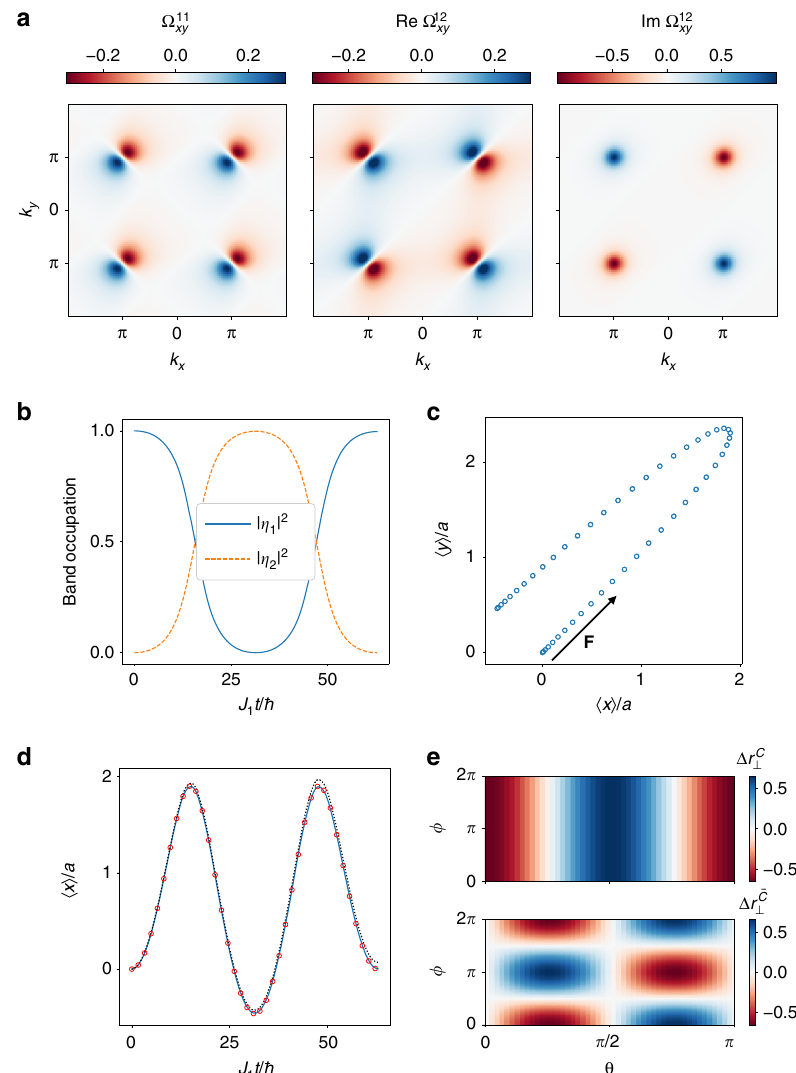
Fig. 2 Time dynamics of multiple BOs. a Non-Abelian Berry curvature Ω xy ( k ) for the BBH model. b Band occupation dynamics along the C path for θ (0) = ffiffiffi p J 0 and ϕ (0) = 0. Here J 2 = 0.3 J 1 and j F j ¼ 0 : 2 2 . c Real-space wavepacket trajectory. d Comparison of the wavepacket x h i position for (solid line) 1 numerical real-space evolution of a wavepacket with width σ = 0.15 a − 1 and momentum grid-spacing k pts = 20, (dashed line) exact evolution, (dots) semiclassical evolution. e Orthogonal displacement Δ r ⊥ after one BO along the paths C and (cid:2) C